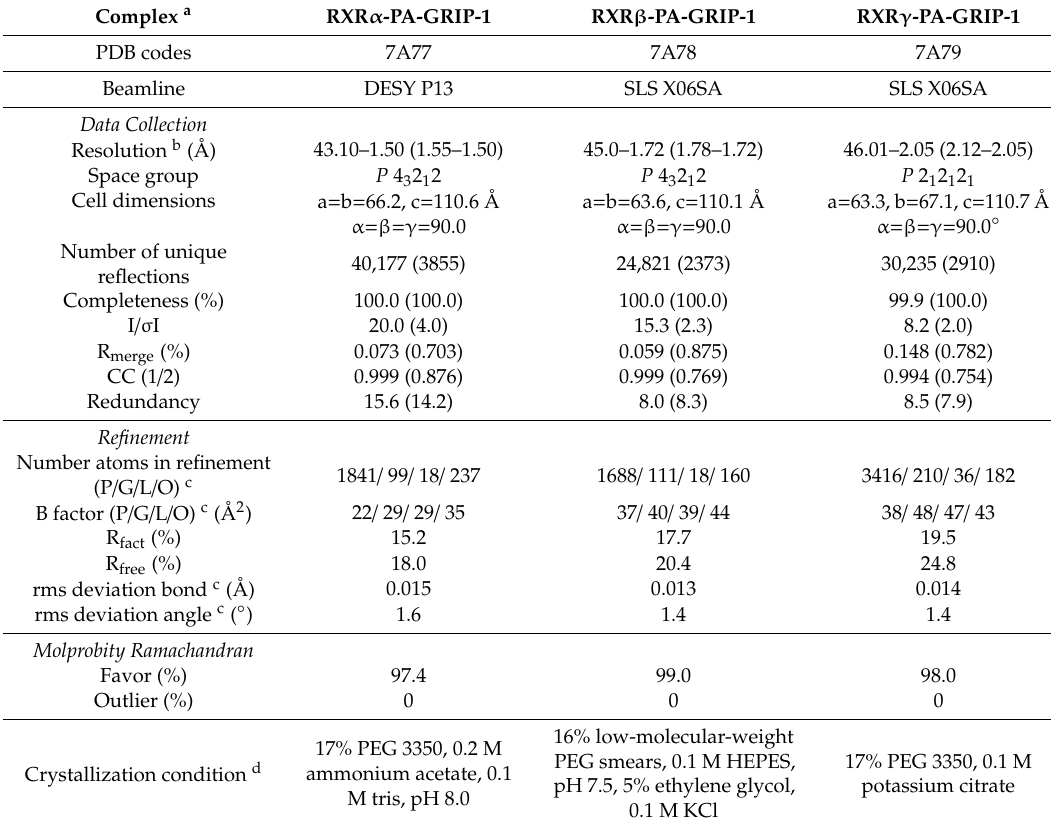
Table 1. Data collection and refinement